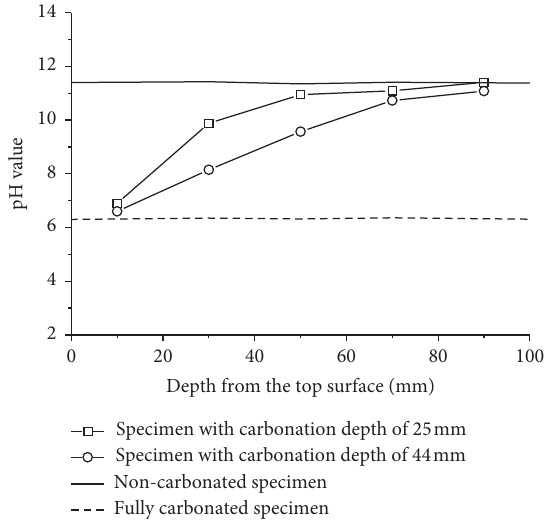
Figure 9: Distribution of pH value in the carbonated